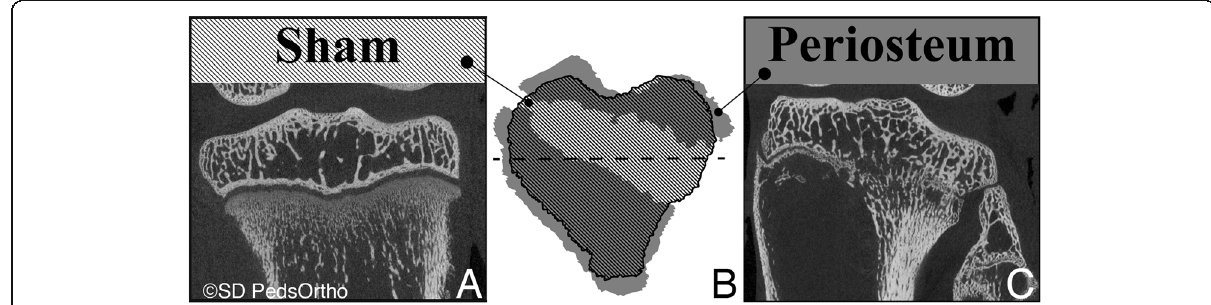
Fig. 3 Example tibia left/Sham ( a ) and right/Periosteum ( c ) mid-coronal reconstructed microCT images. Middle image ( b ) is the schematic axial view of the right side (grey) and left (striped), superimposed and mirrored. Dashed line in B shows location of Fig. 3a and